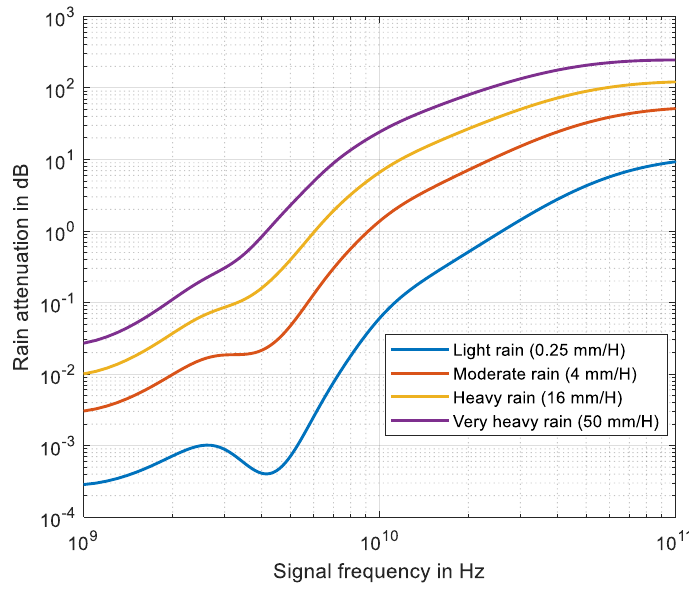
Figure 17. Rain attenuation at maximum aircraft – SB LOS distance communication.